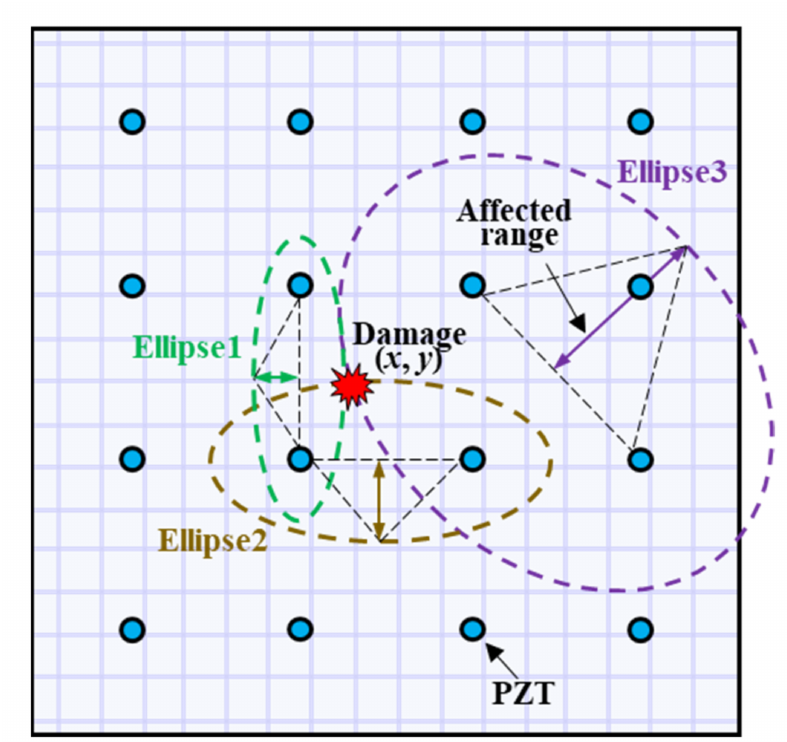
Figure 17. Damage identification based on the PDI method with variable shape